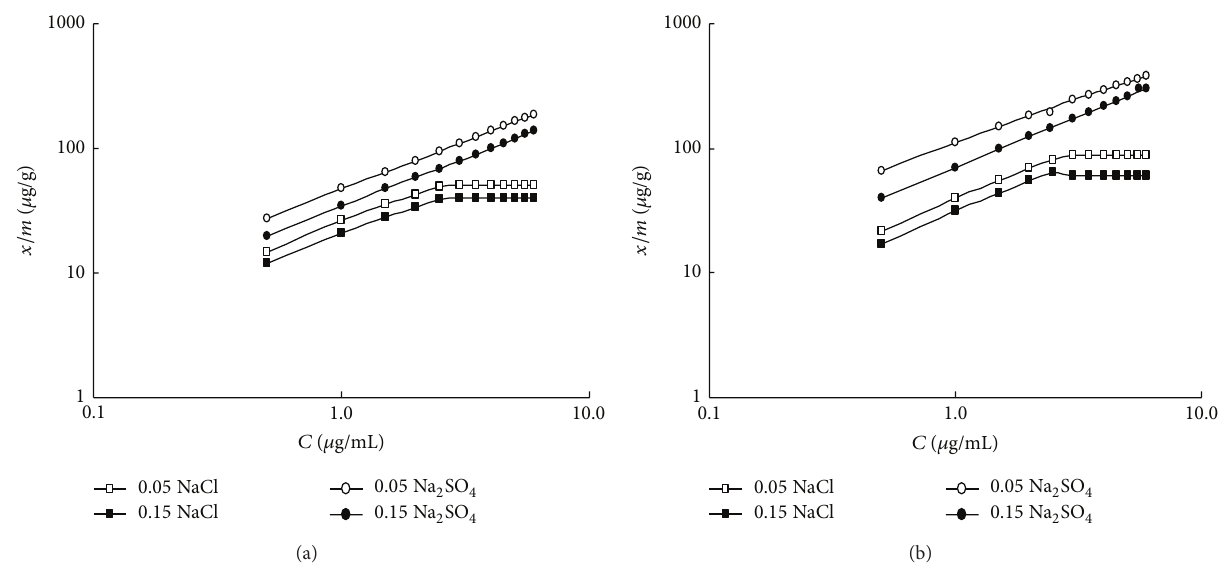
Figure 3: Freundlich plots of cadmium adsorption by (a) alluvial soil and (b) calcareous soil, at different concentrations of NaCl and Na 2 SO 4 as electrolyte matrices.